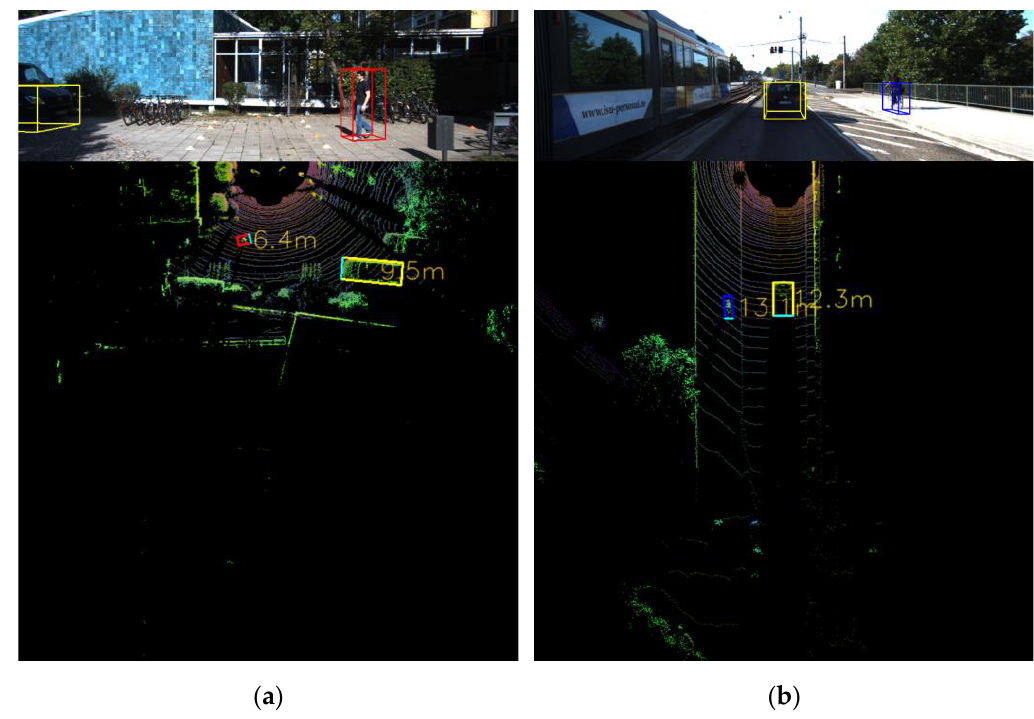
Figure 7. Distance estimation for different class objects: ( a ) car and pedestrian; ( b ) car and cyclist.